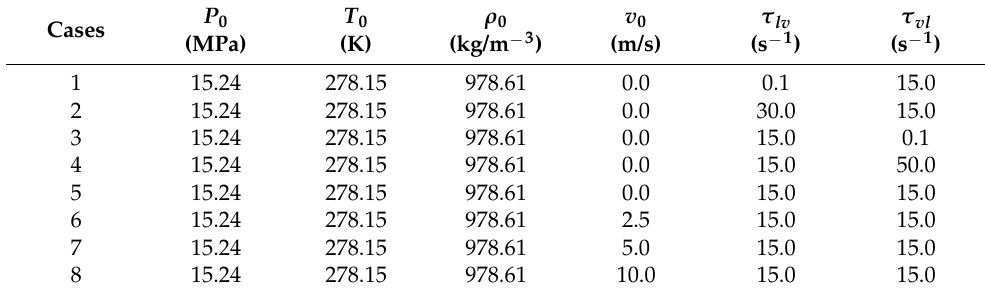
Table 1. Initial computational parameters of